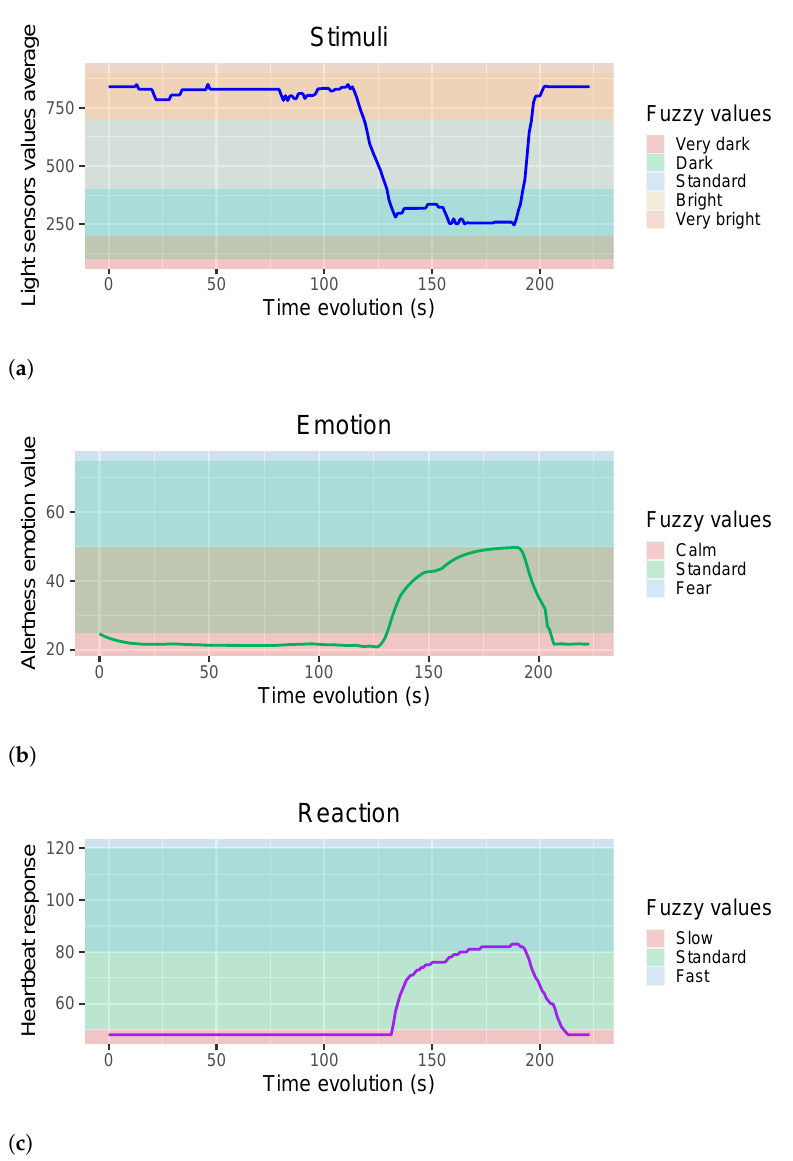
Figure 12. Experiment one results. ( a ) Light sensors’ average values. ( b ) ALERTNESS emotion in function of the light stimuli. ( c ) Heartbeat speed in function of the emotional